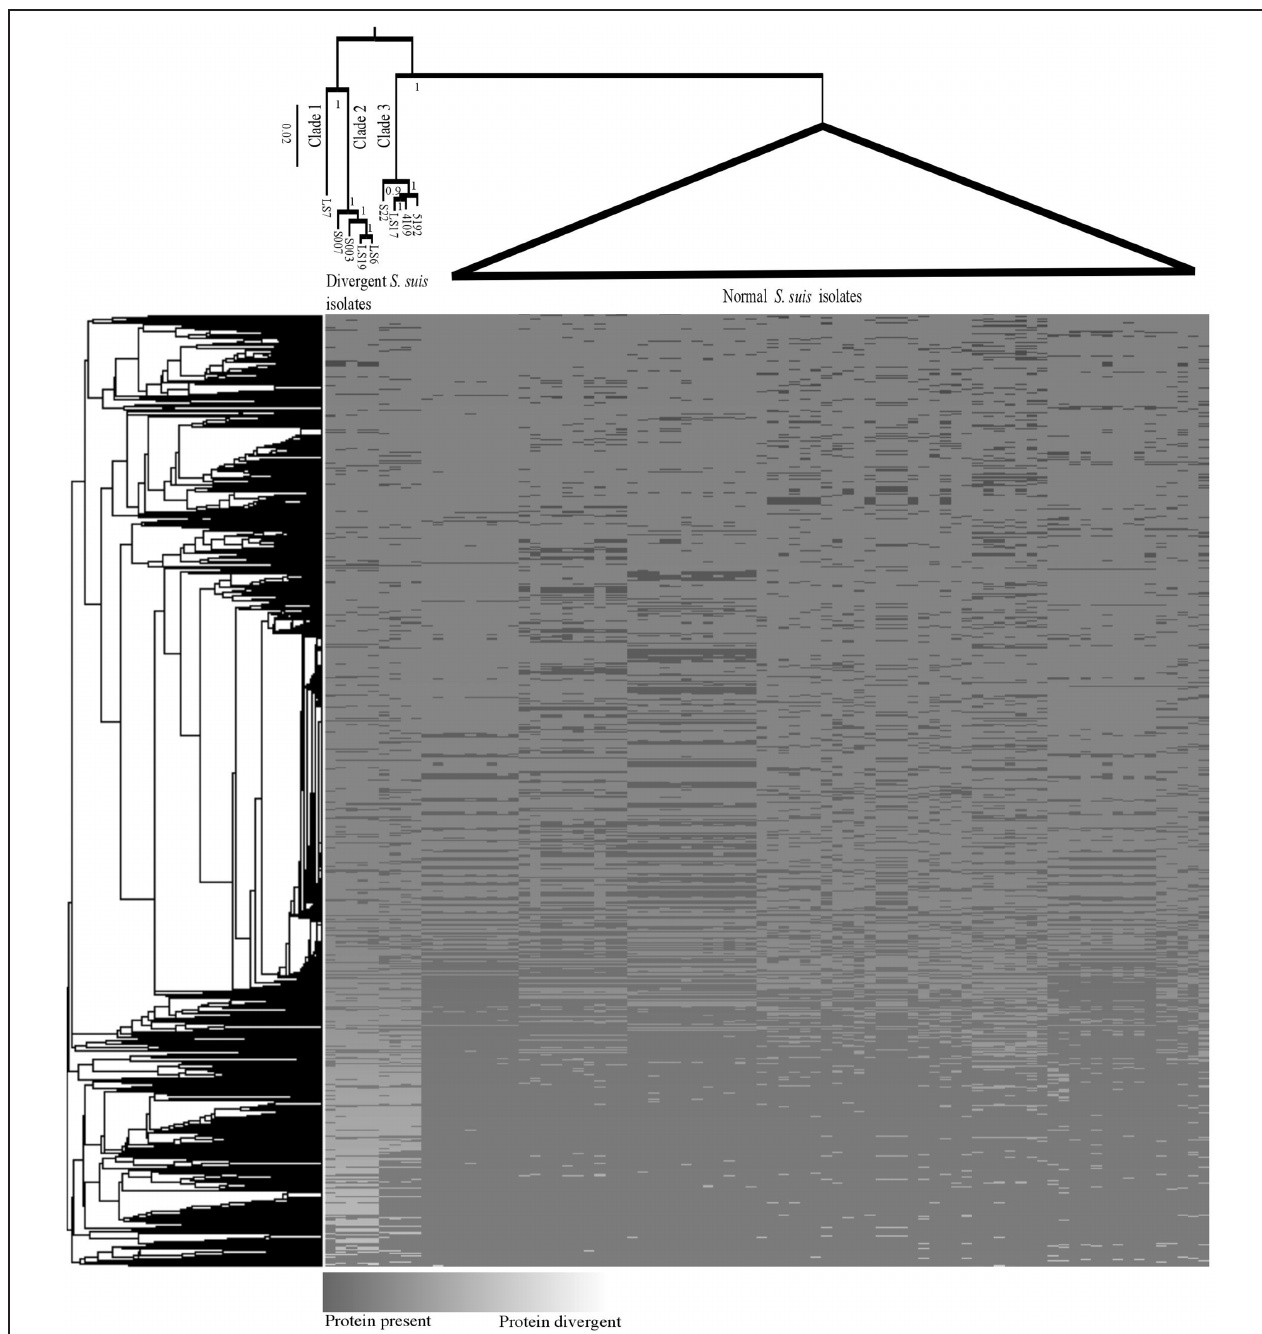
FIGURE 1 | Maximum likelihood phylogeny (top) of core genes for the divergent and normal Streptococcus suis isolates. The branches with normal S. suis isolates have been collapsed. A heatmap showing the presence/divergence of proteins in the S. suis pan-genome and a cluster grouping those genes that co-occur in the same isolates